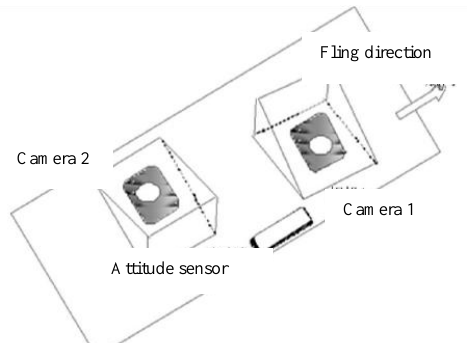
Figure 6. The mechanical structure of double-combined camera